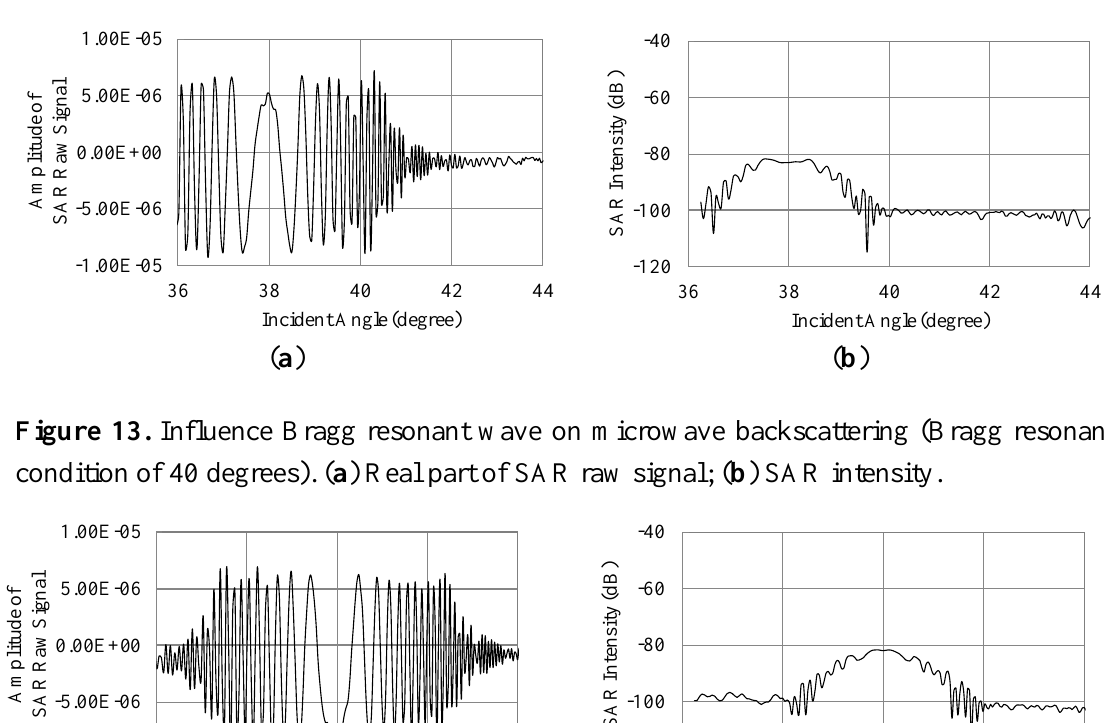
Figure 12. Influence Bragg resonant wave on microwave backscattering (Bragg resonant condition of 38 degrees). ( a ) Real part of SAR raw signal; ( b ) SAR intensity.